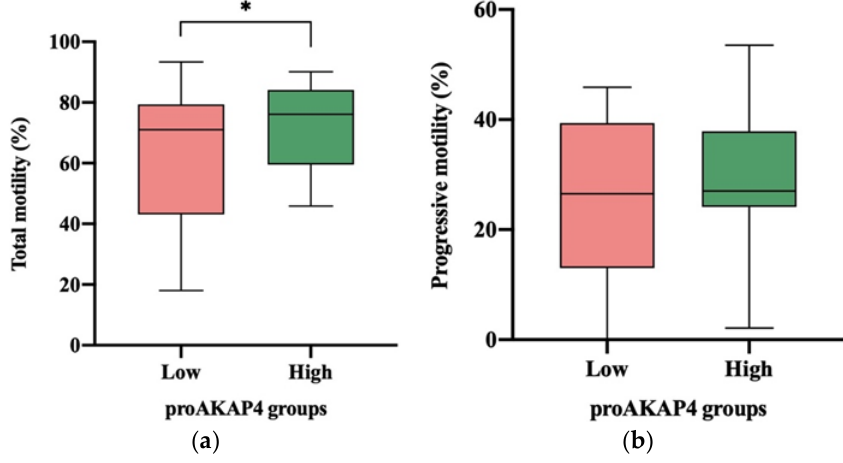
Figure 3. Box–whisker plot showing the differences in total ( a ) and progressive ( b ) motility of frozen–thawed horse ejaculates as having low (n = 23; red) or high (n = 25; green) proAKAP4 concentration (ng/10M spz). The line indicates the median, the boxes enclose the 25th and 75th percentiles, and the whiskers extend to the 5th and 95th percentiles. * p ≤ 0.05. Four sperm motile subpopulations were identified in frozen–thawed horse ejaculates (Table 1). Subpopulation 1 (SP1) was the fastest (higher values of VCL, VSL, and VAP), with intermediate values of LIN, STR, and WOB, and with ALH also intermediate and BCF higher. Subpopulation 2 (SP2) presented intermediate speed values, but was the most progressive, with higher values of LIN, STR, and WOB, and with intermediate ALH and BCF. Subpopulation 3 (SP3) was the slowest, with intermediate values of LIN, STR, and WOB, and with the lowest ALH and BCF values. Finally, subpopulation 4 (SP4) also presented intermediate speed values, but it showed low values of LIN, STR and WOB, although it had the highest ALH and intermediate BCF. Table 1. Structure (mean ± SEM; range) of the four motile sperm subpopulations (SP) identified in frozen – thawed horse ejaculates (n = 48).